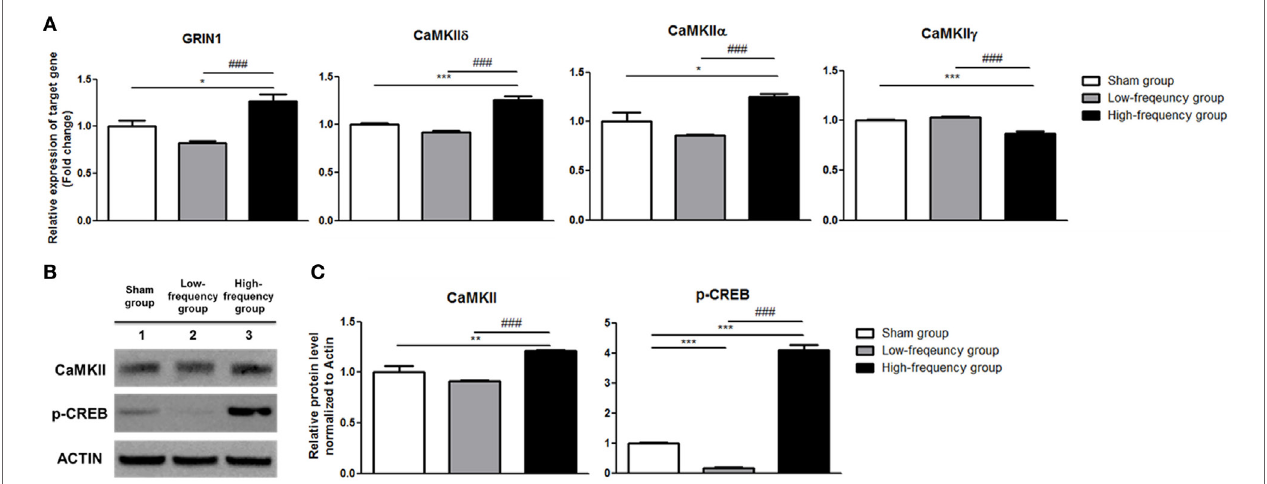
FigUre 2 | Validation of mRNA expression and protein quantification using qRT-PCR and western blot analysis in undifferentiated Neuro-2a cells. (a) The relative mRNA expression of target genes was normalized by sham expression and was calculated using the 2 −ΔΔ Ct method by qRT-PCR. All results are expressed as means ± SEM. (B) Western blot analysis was performed using antibodies against calmodulin-dependent protein kinase II (CaMKII), phospho-cAMP response element binding (p-CREB), and actin (a control). All results are expressed as means ± SEM. (c) Comparison of relative protein expression for CaMKII, p-CREB, and actin (a control) with Multi Guage (v3.0) software (Fujifilm). * p < 0.05, ** p < 0.01, and *** p < 0.001 comparison with the sham group in undifferentiated Neuro-2a cells. ### p < 0.001 comparison with the low-frequency group in undifferentiated Neuro-2a